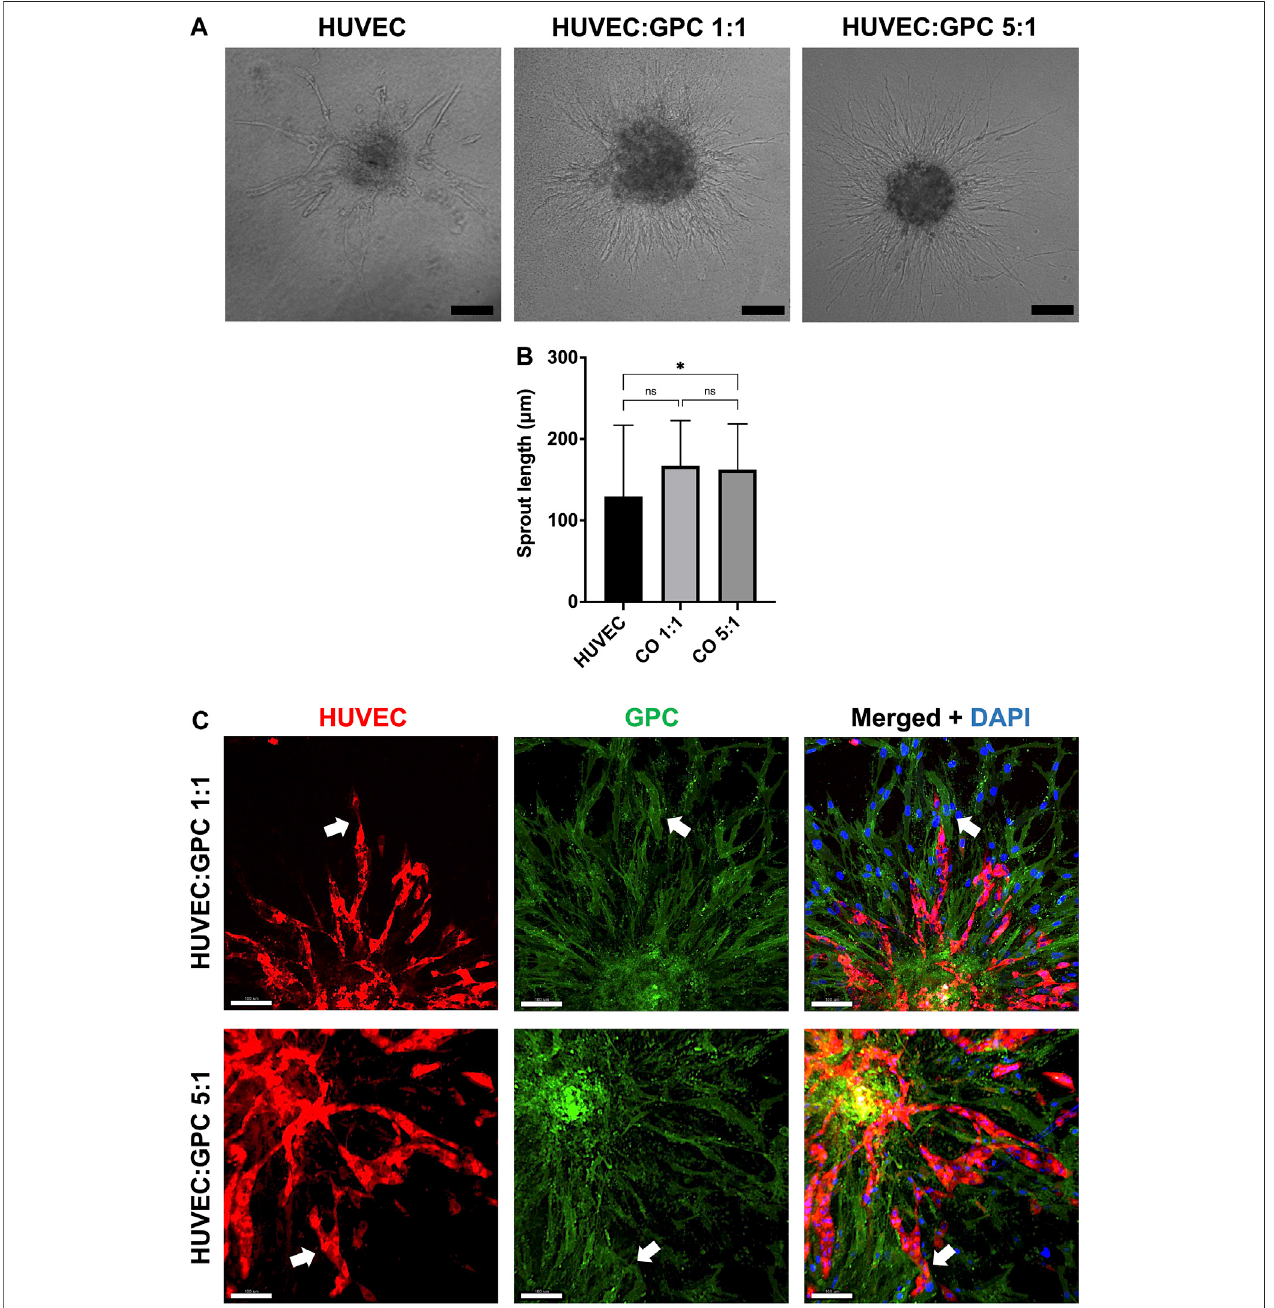
FIGURE 3 | Coculture of GPC and EC in HPLG. (A) Representative images of HUVEC sprouting (and GPC spreading) in HUVEC monoculture and 1:1 and 5:1 (HUVEC:GPC) coculture spheroids after 72 h in unmodi fi ed HPLG (scale bars 100 μ m). (B) Quanti fi cation of corresponding sprout lengths based on dual-staining and confocal imaging – only red-stained HUVEC sprouts were measured; * p < 0.05; data represent means ± SD of at least three experimental repeats (n ≥ 5 spheroids per experiment). (C) Representative confocal images showing sprout formation in 1:1 and 5:1 HUVEC:GPC coculture spheroids; white arrows indicate GPC (green) organization along HUVEC sprouts (red;); nuclei are stained with DAPI (scale bars 100 µm).